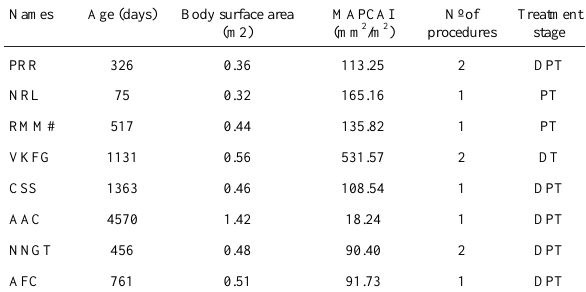
Table 3. Morphometric characteristics of the major aortopulmonary collateral arteries, surgical procedures and treatment stages in relation to the age and the body surface area in Group